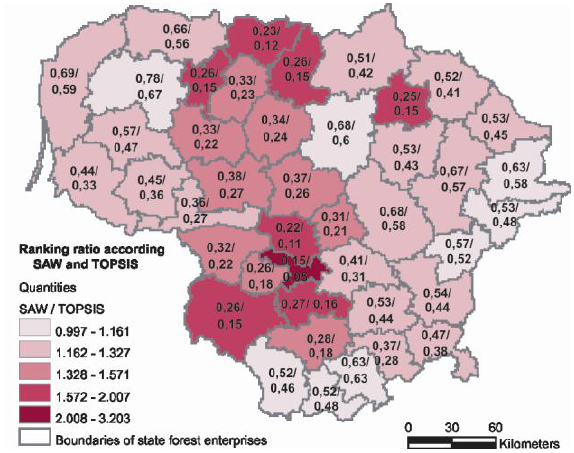
Fig. 6. Forest fragmentation component maximum area size based ranking of Lithuanian state forest